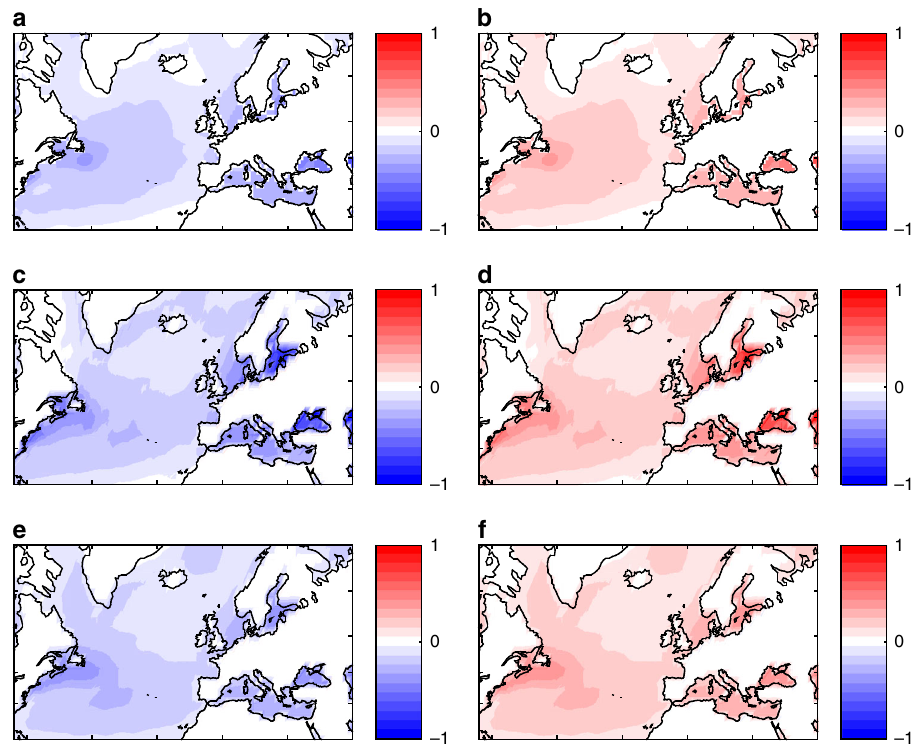
Fig. 3 Composite sea-surface temperature anomalies for high and low local dimension. Composite sea-surface temperature anomalies (units: K) with respect to the climatological seasonal cycles for days with d SST above ( a , c , e ) and below ( b , d , f ) the respective median values. Datasets: COBE, as used in 20CRv2c ( a , b ), ERA20CM ( c , d ) and CERA20C ( e , f